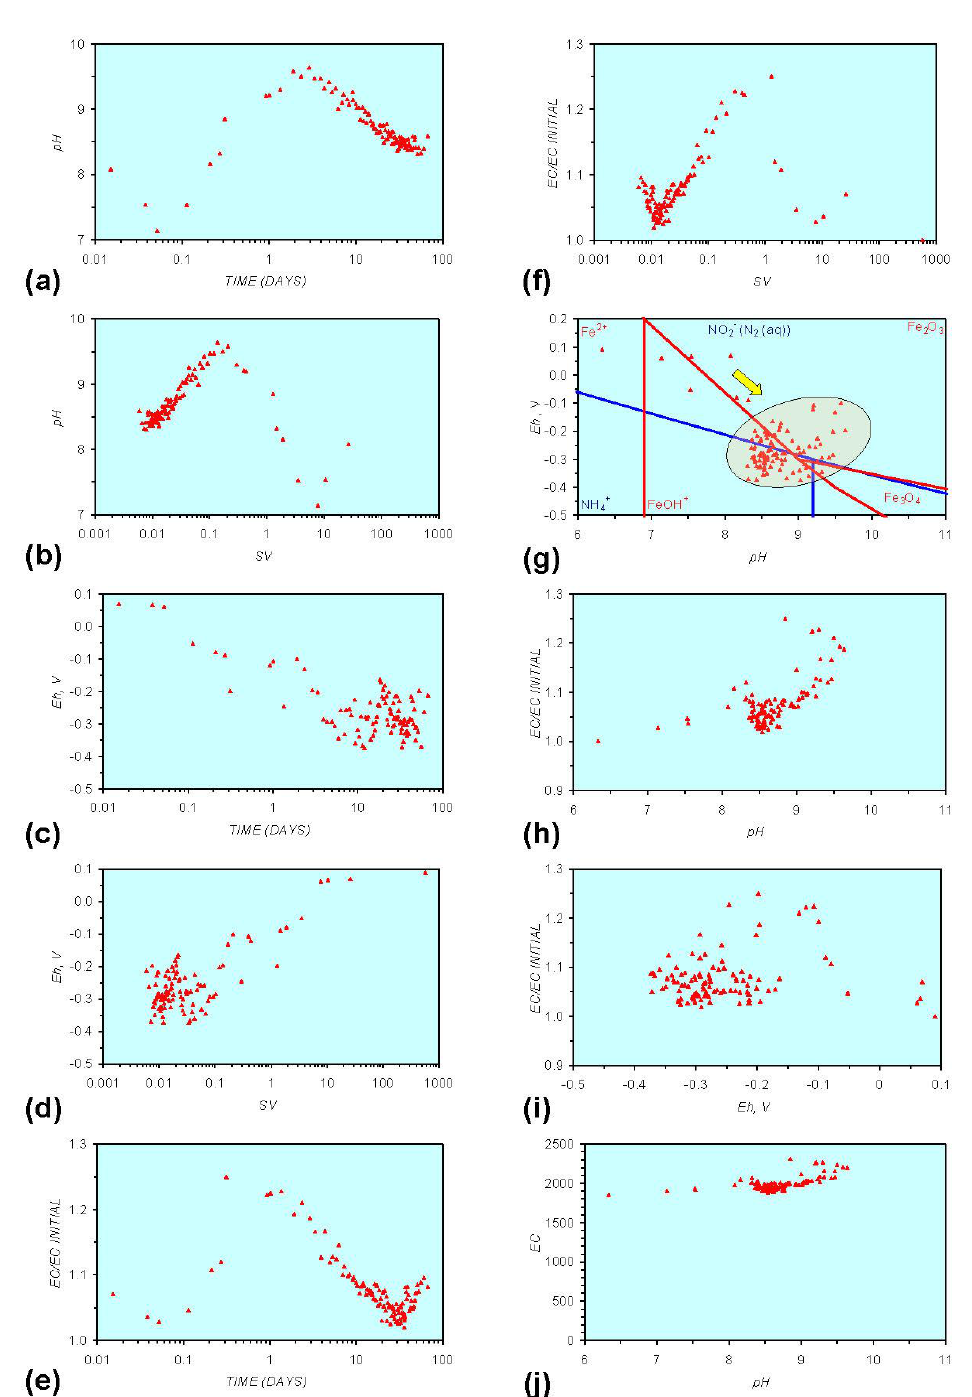
Figure A16. MR11: Ca-montmorillonite + n-Fe 0 + n-Cu 0 + n-Al 0 , saline water. (a) pH vs. Time; (b) pH vs. SV; (c) Eh vs. time; (d) Eh vs. SV; (e) EC/EC Initial vs. time; (f) EC/EC Initial vs. SV; (g) Eh vs. pH (SRE ringed); (h) pH vs. EC/EC Initial; (i) Eh vs. EC/EC Initial; (j) pH vs. E(C) Arrows indicate decreasing SV and increasing